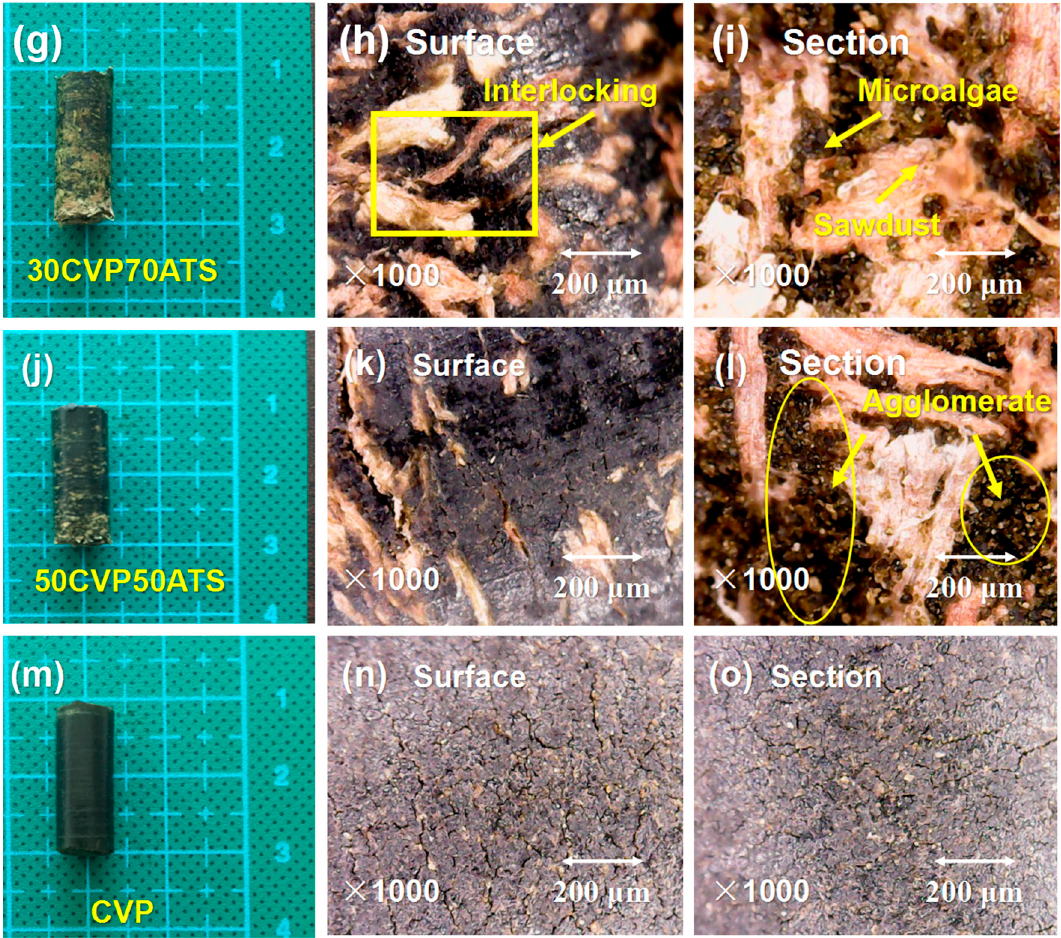
Figure 7. Sample appearance, surface (×1000), and section (×1000) under parameters of temperature (120 °C), pressure (100 MPa), and moisture content (10%): ( a–c ) ATS, ( d–f ) 15CVP85ATS, ( g–i ) 30CVP70ATS, ( j–l ) 50CVP50ATS, and ( m–o ) CVP.